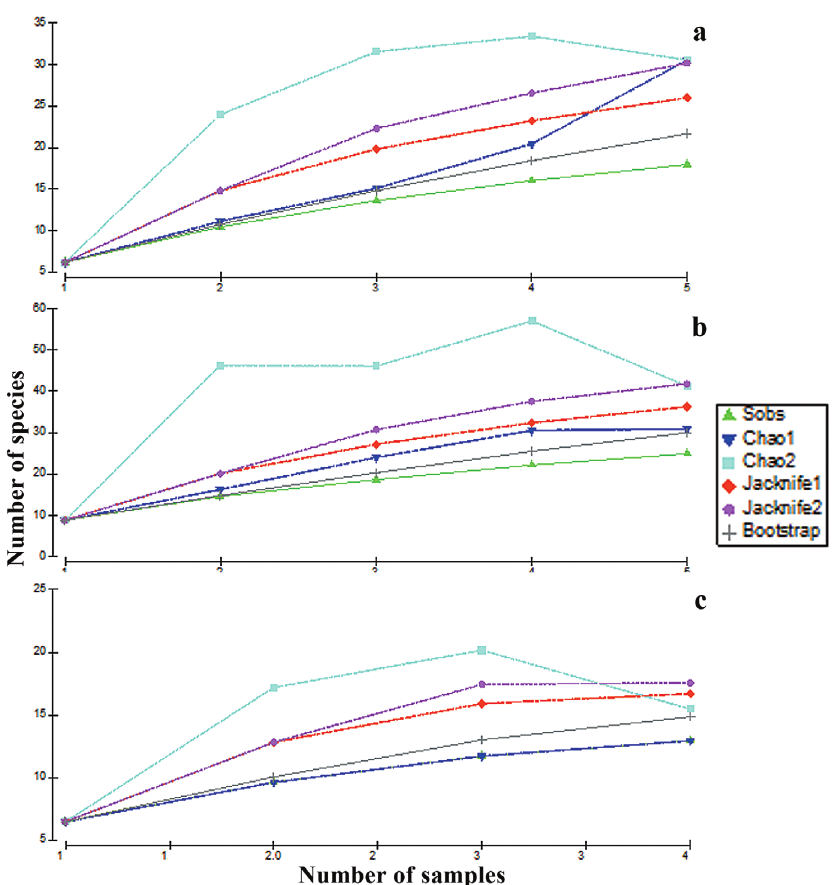
Figure 3. Completeness of the inventory of species determined by different richness estimators at the Taim nature reserve (ESEC Taim). a, Estimations for lake Nicola (S1); b, Estimations for the water channel (S2); c, Estimations for lake Mangueira (S3) (Sobs: observed